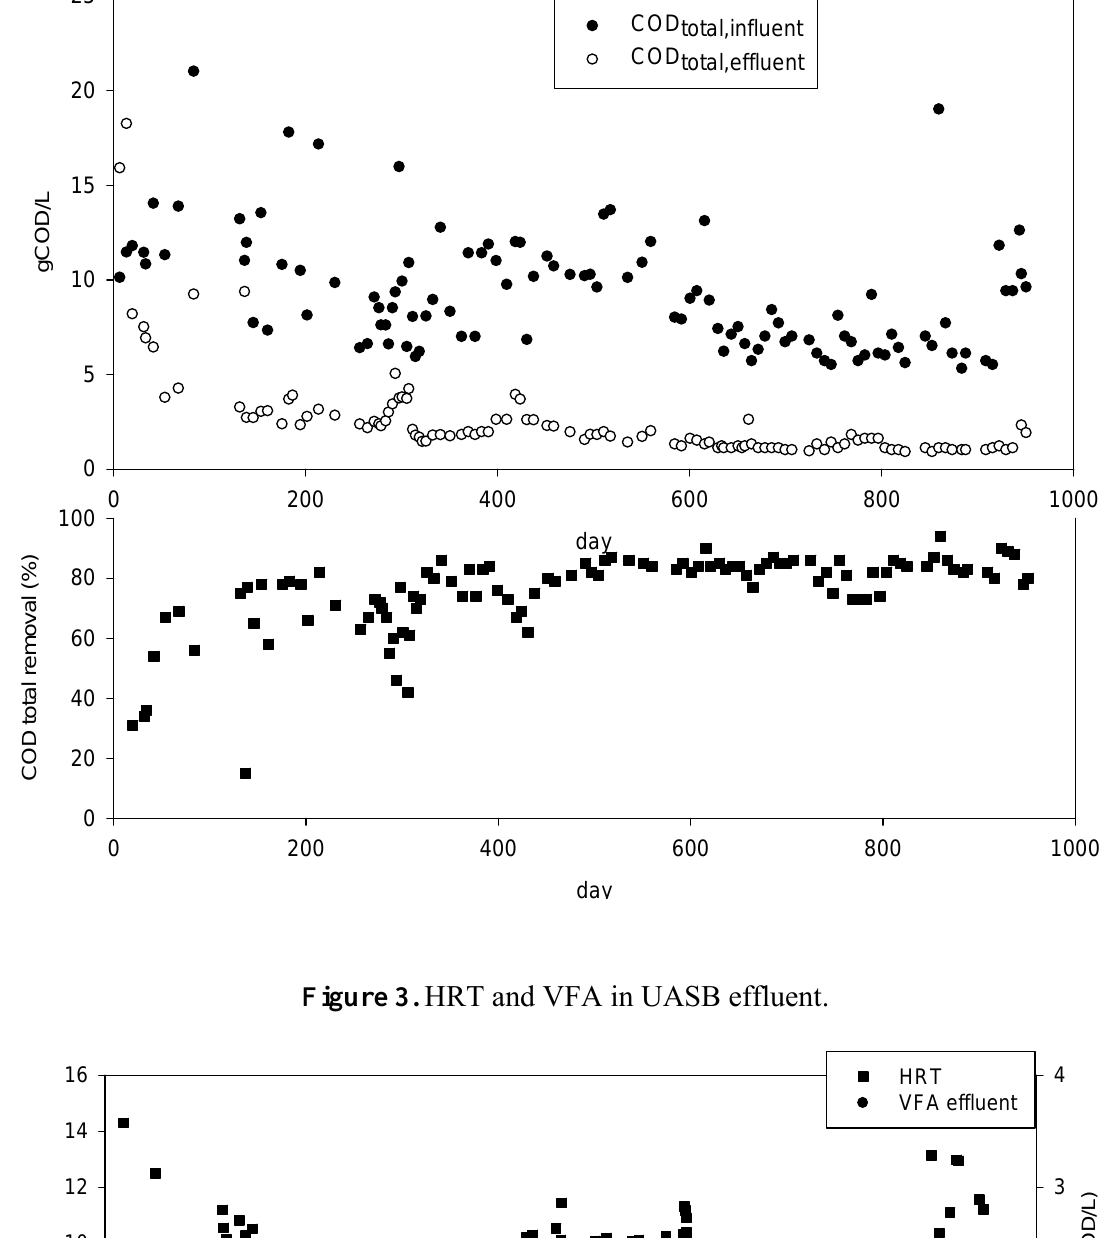
Figure 2. Influent and effluent COD concentrations and the COD total removal of the UASB reactor.